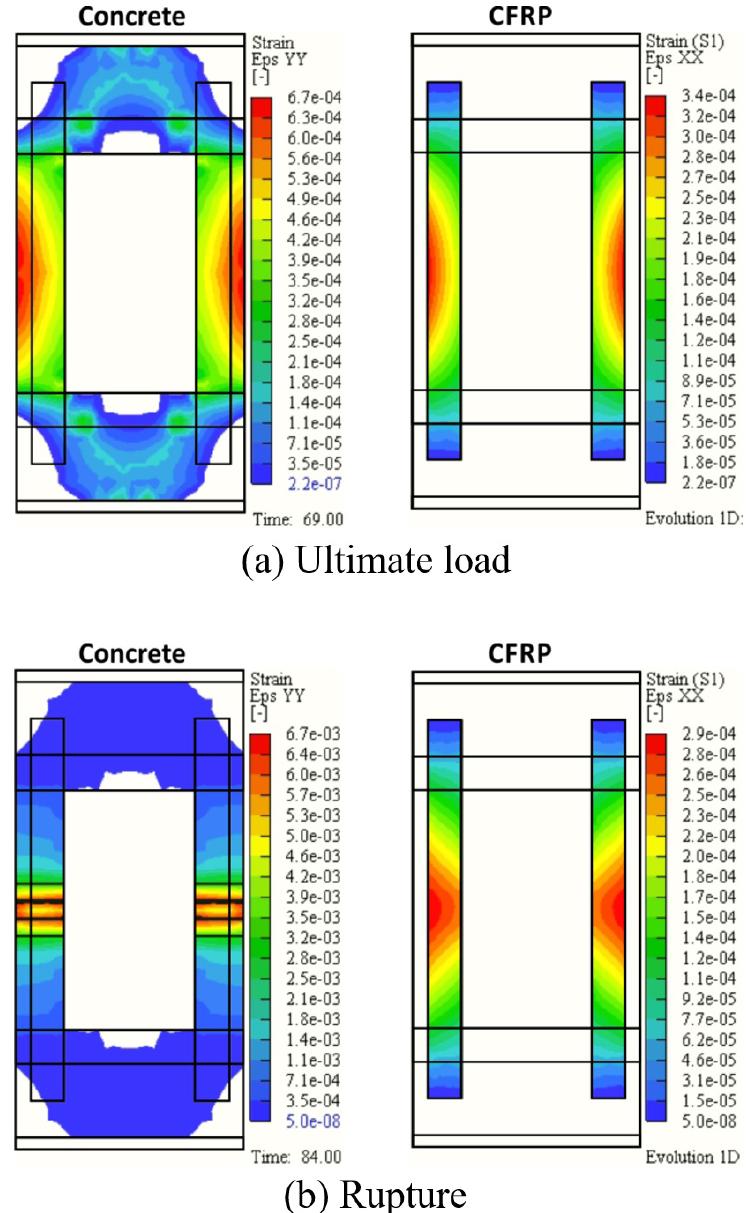
Figure 15. Vertical strain in the concrete and the CFRP